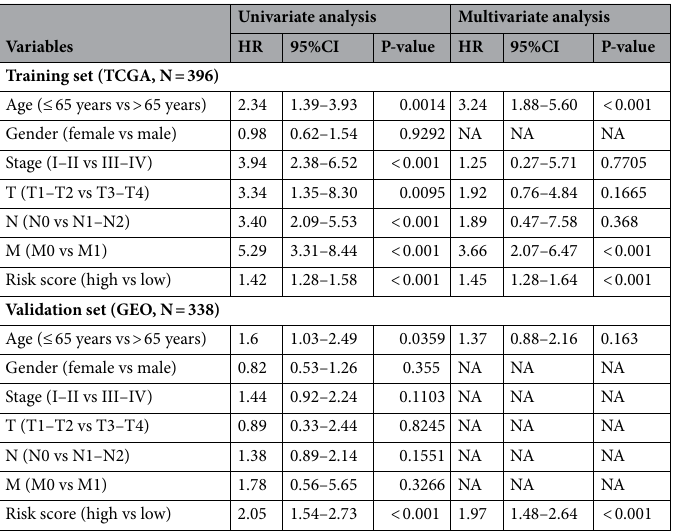
Table 1. The prognostic value of different clinical characters in the TCGA and GEO. NA not